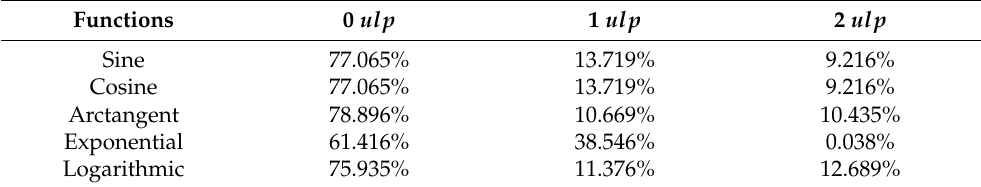
Table 3. Hardware accuracy.